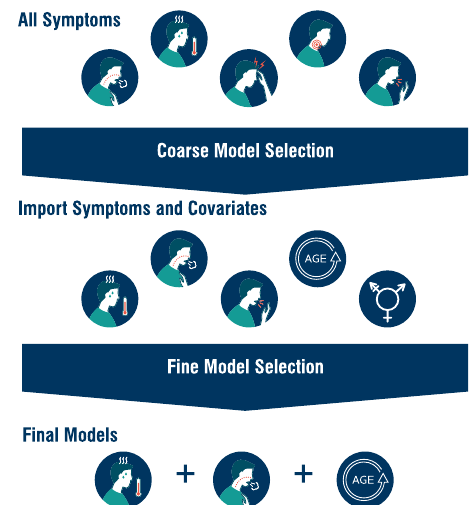
Fig. 5 Model selection procedure. Rounds of model selection in the multivariate probit component of the Syndromic-only and Syndromic-Rapid Antigen Test (RAT) Combined models. With 14 symptoms (5 shown for demonstration purposes) and 2 covariates there are over 131,000 possible model combinations. To make exploring these models computationally feasible and to reduce the risk of over fi tting, we carried out two rounds of model selection. A subset of symptoms are identi fi ed using the strength of posterior correlation between each symptom and PCR status identi fi ed by the corresponding model, with the weakest correlated symptoms removed during each round of selection. From this subset of symptoms, a more exhaustive search of potential models is then conducted to identify the best symptom-covariate relationships, using temporal cross-validation to measure model performance. The best model for each level of complexity (i.e., number of symptoms) are then used as our candidate models. Only these fi nal models are used for classi fi cation. This reduces the set of models tested as classi fi ers from >131,000 to just four per model